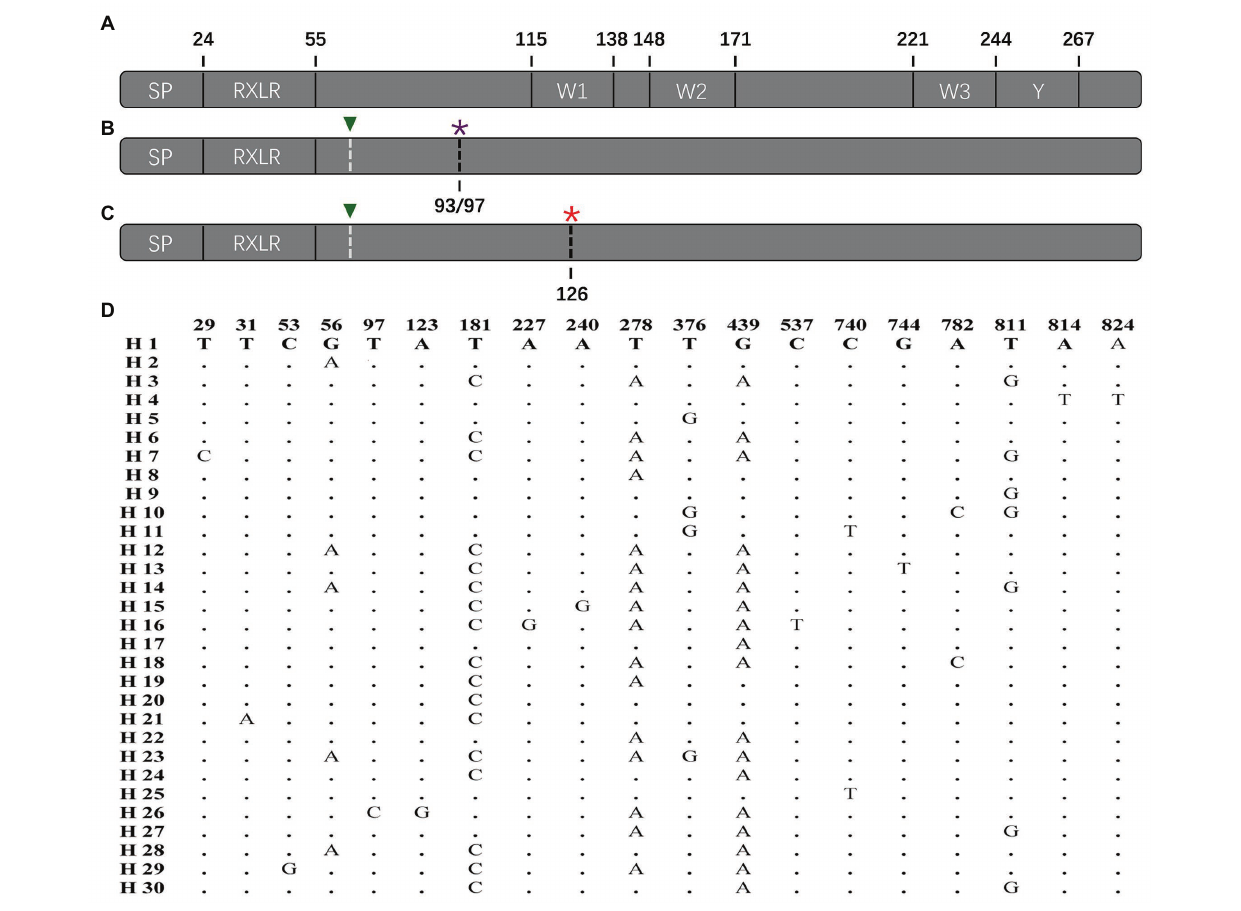
TABLE 2 | Pairwise population differentiation ( FST ) in SSR marker loci (above diagonal) and Avr4 gene (below diagonal). Fujian Gansu